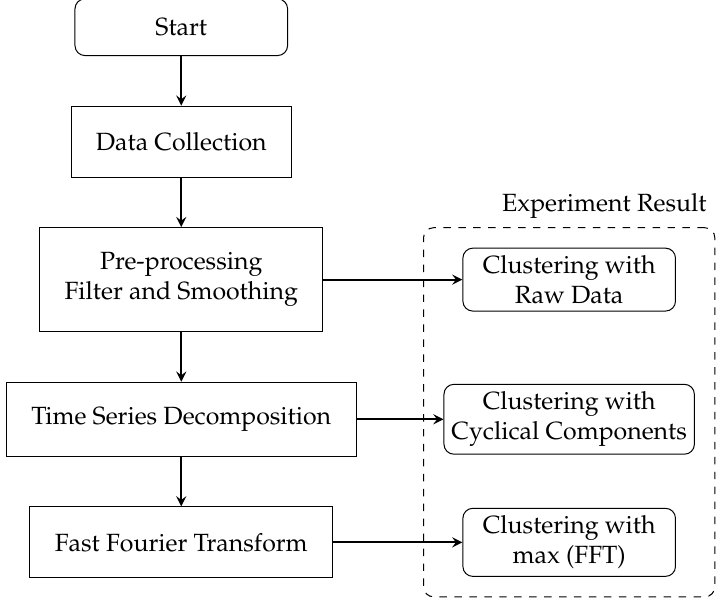
Figure 3. Experiment flow